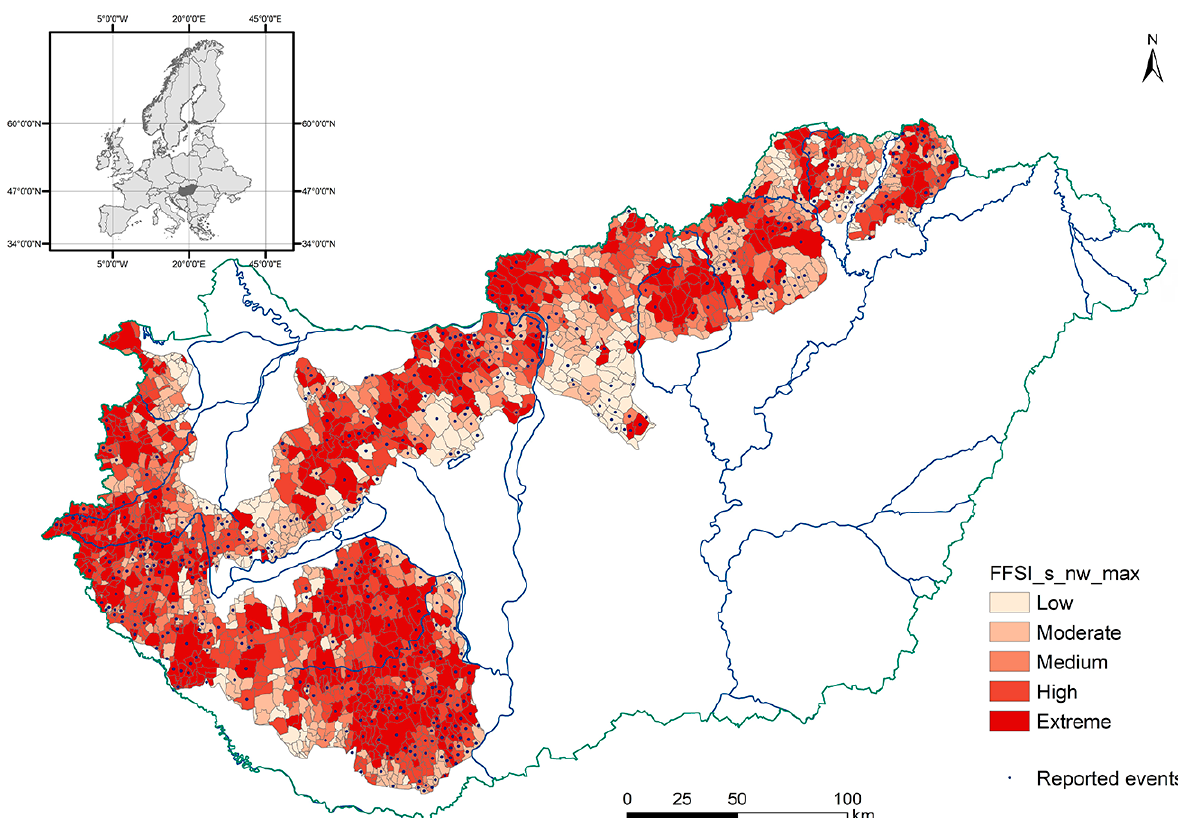
Figure 3. FFSI map of Hungary with the maximum raster value used for susceptibility assignment s